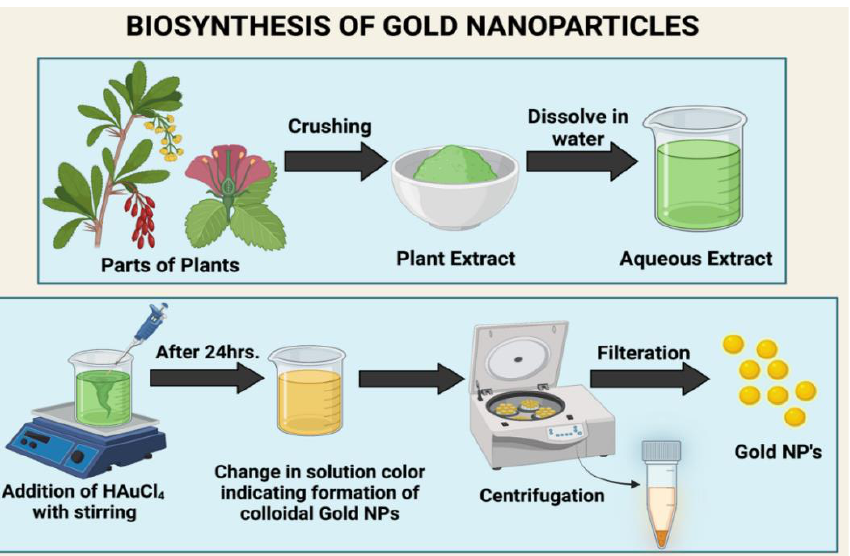
Figure 1. Illustration of the laboratory synthesis of gold NPs using plant extracts (created using Biorender.com, accessed on 10 January 2022).